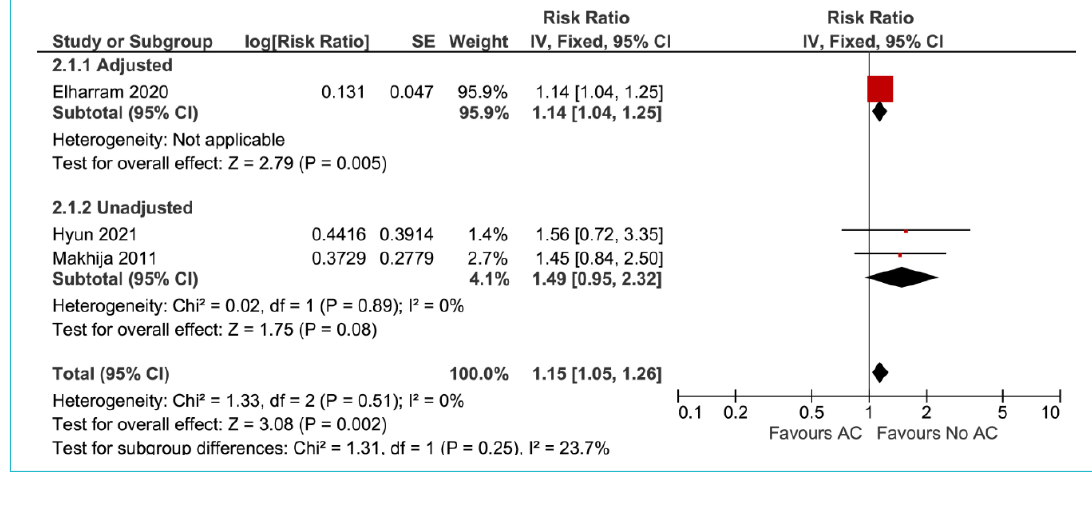
Table 2: Summary of study results. Outcome N of participants (N of